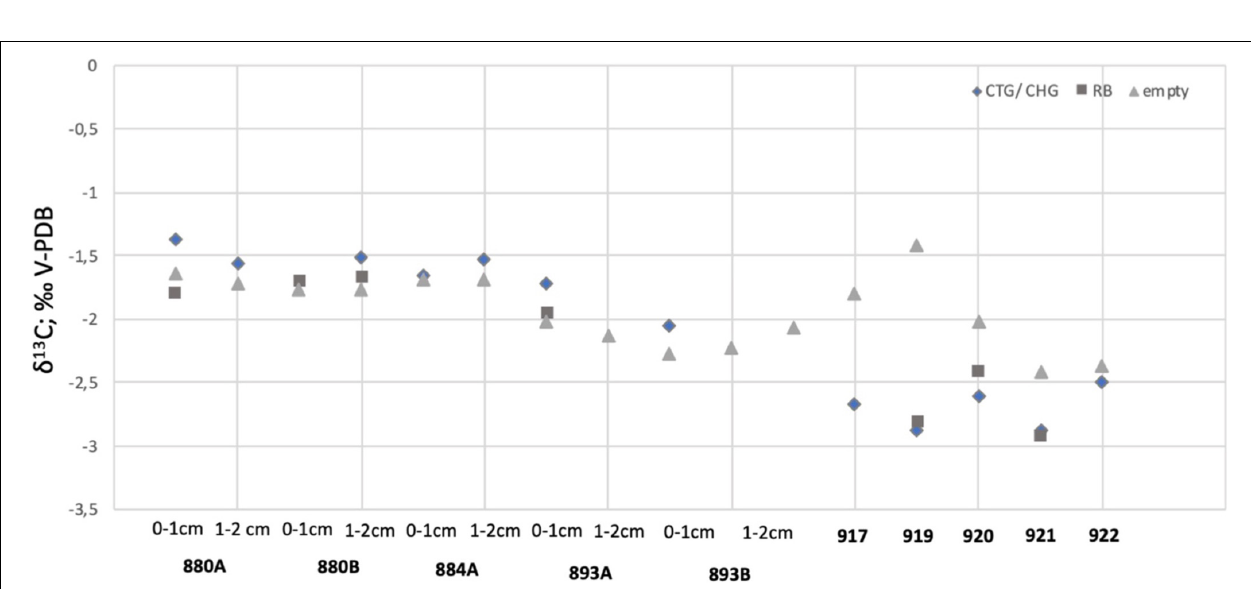
FIGURE 9 | The δ 13 C values measured in CellTracker TM Green labeled (CTG), CellHunt Green labeled (CHG), Rose Bengal stained (RB), and empty tests of Melonis barleeanus .